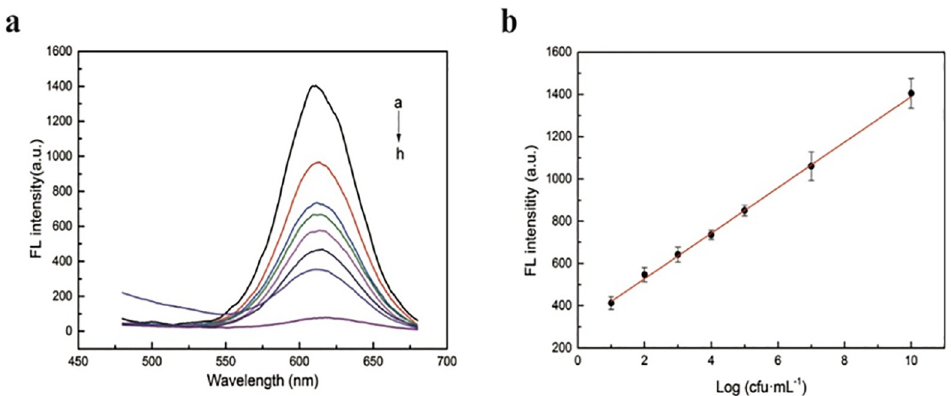
Fig 7. ( a ) Fluorescence spectra of aptasensors with different concentrations (from a to h: 10 10 , 10 7 , 10 5 , 10 4 , 10 3 , 10 2 , 10, 0 cfu•mL -1 ) of S . Typhimurium ; ( b ) calibration curve of the fluorescence intensity of the QDs@ssDNA2 at 612 nm for S . Typhimurium detection.